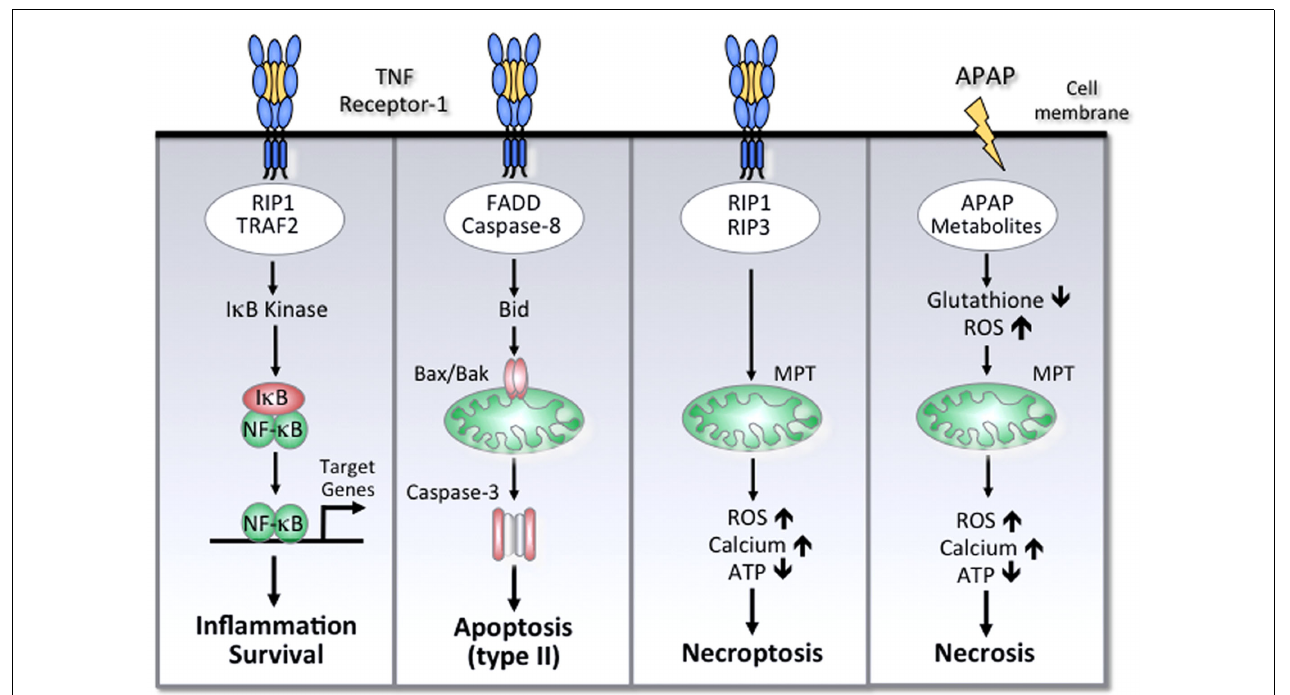
FIGURE 1 | Simplified scheme of cell death and survival pathways involved inALF. Activation ofTNF receptor-1 can mediate NF- κ B activation, apoptosis, or necroptosis.The different outcomes are determined by distinctTNF receptor-associated signaling complexes. Activation of NF- κ B is mediated byTRAF-2, RIP-1, and other signaling molecules that lead to activation of I κ B kinase and subsequent activation of NF- κ B target genes. FADD and caspase-8 are the essential adapter proteins involved in apoptosis, which in hepatocytes requires a mitochondrial amplification loop through caspase-8-mediated cleavage of Bid.The subsequent translocation of Bax and Bak results in mitochondrial outer membrane permeabilization, cytochrome c release, and effector caspase-3